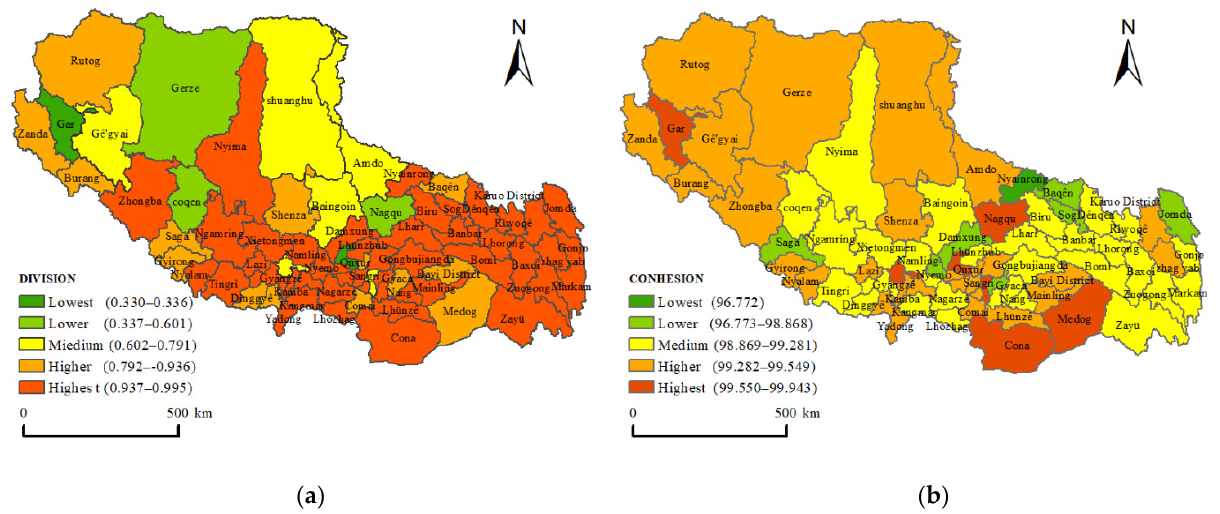
Figure 9. DIVISION and COHESION index spatial distribution maps by county. ( a ) DIVISION is degree of landscape division and ( b ) COHESION is cohesion index of patch.